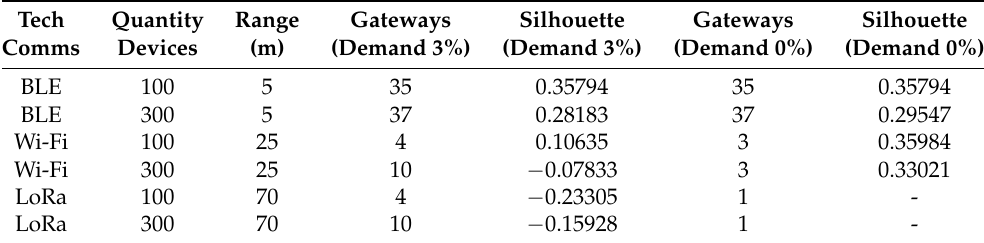
Table 9. The number of required gateways considering the INF area and bandwidth consumption